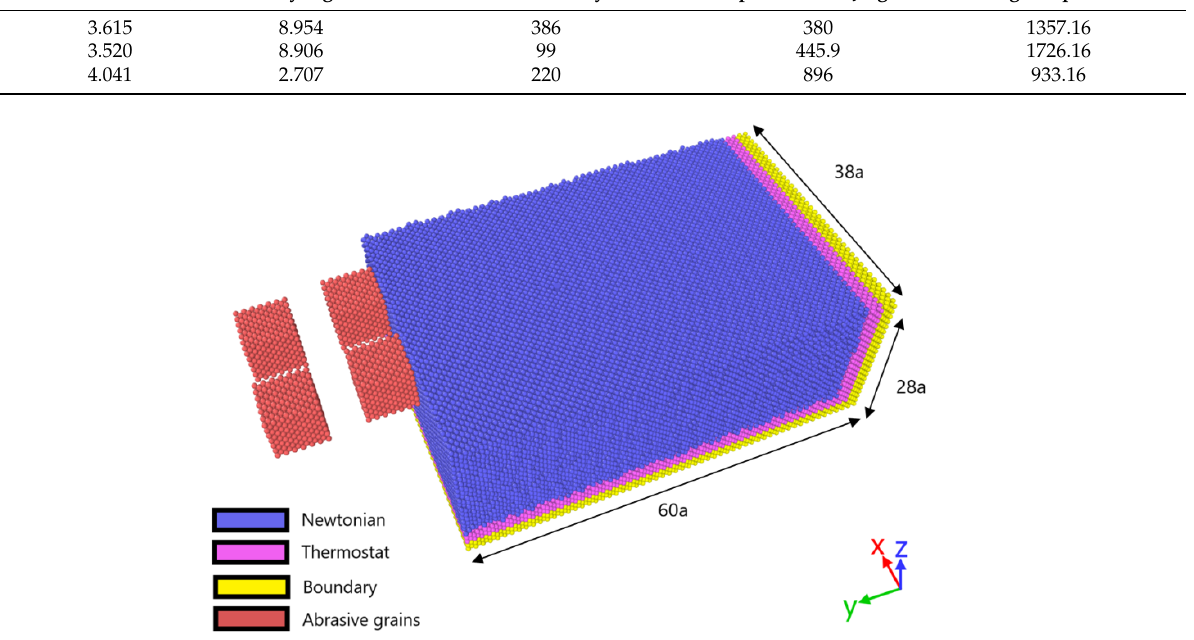
Figure 1. Schematic of the MD model used in the simulations.